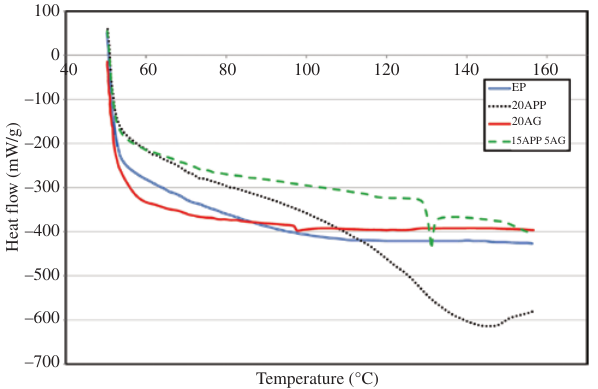
Figure 4: DSC curves of different samples.